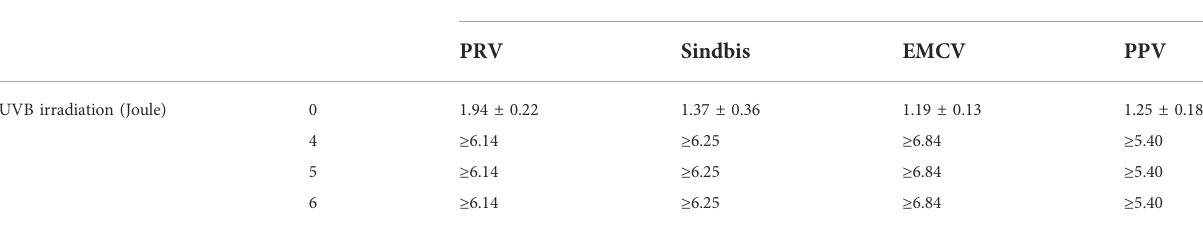
TABLE 3 Viral reduction of chorion (values in log) by UV-RB.